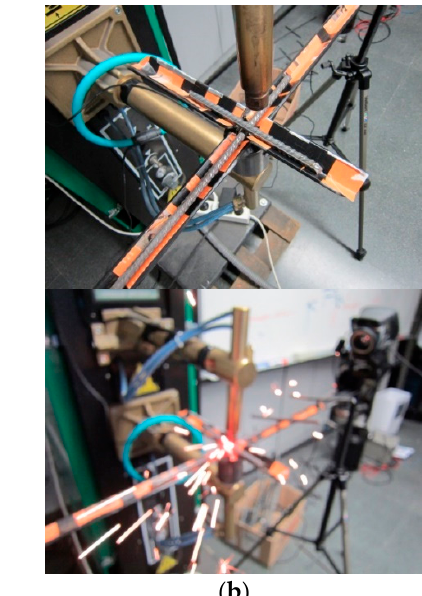
Figure 3. ( a ) MPH Digital Neumática welding equipment and ( b ) fixture zoom and the welding process.